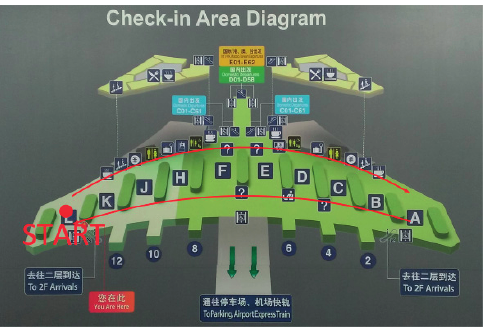
Figure 6. Floor 4 layout of Terminal 3 (the image is from the guide in the terminal). The red lines indicate the